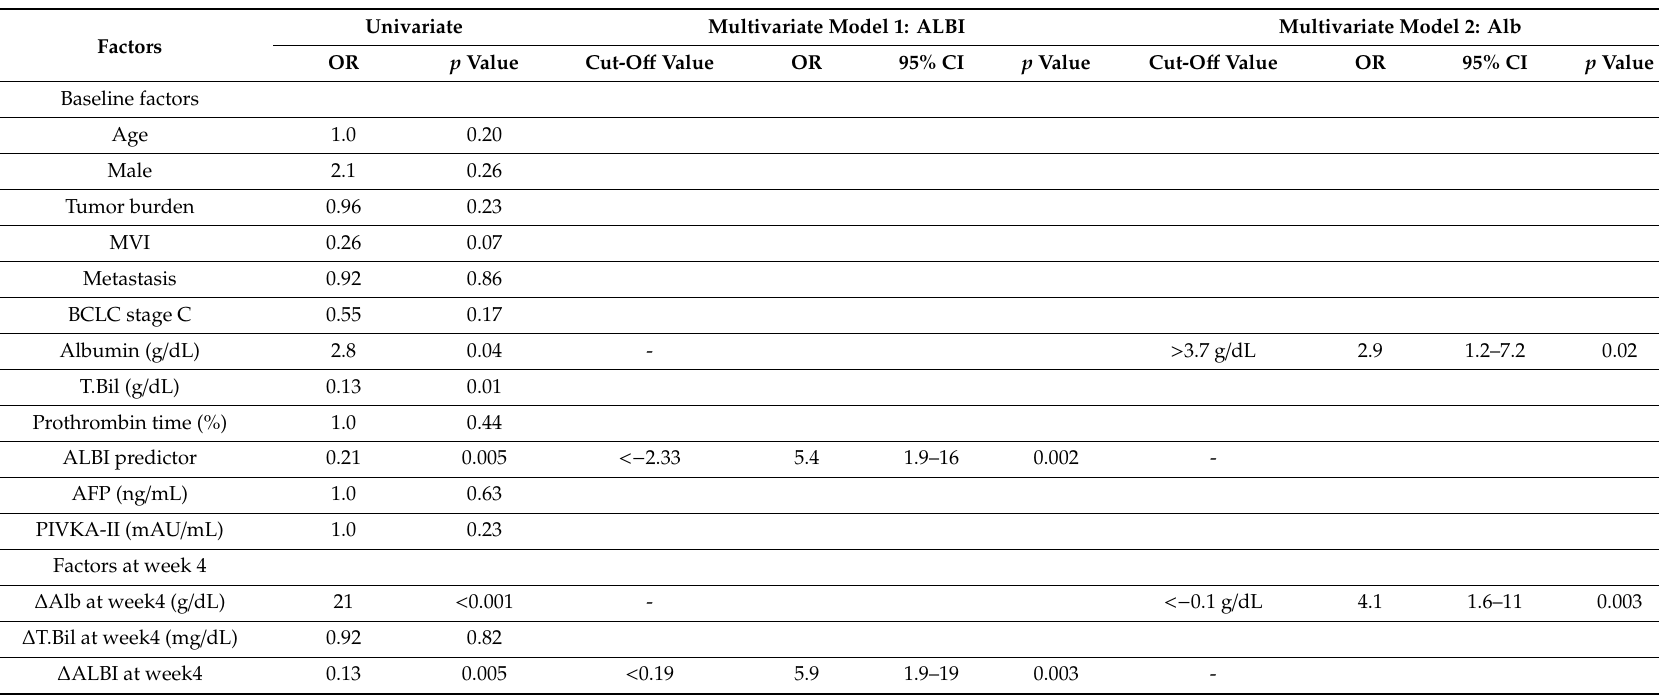
Table 3. Factors to fulfill the RESORCE study’s inclusion criteria plus Child–Pugh score 5 at the time of radiological progressive